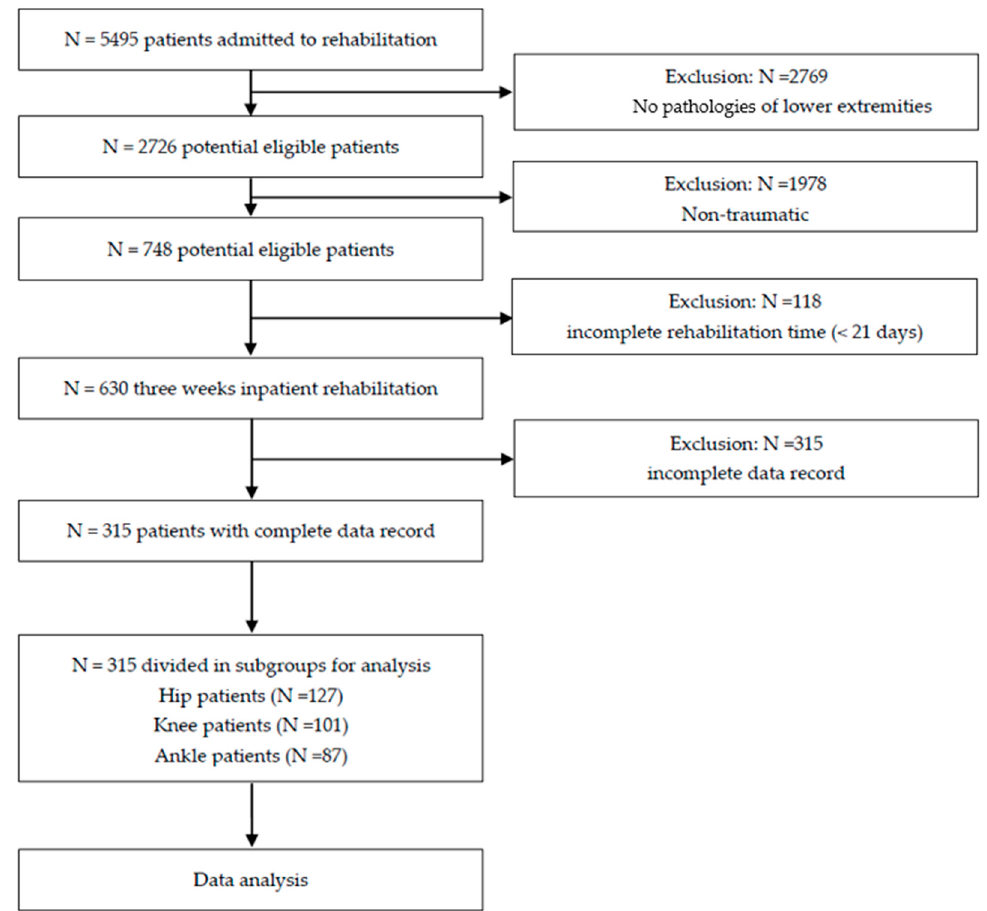
Figure 1. Flow diagram of study participants.